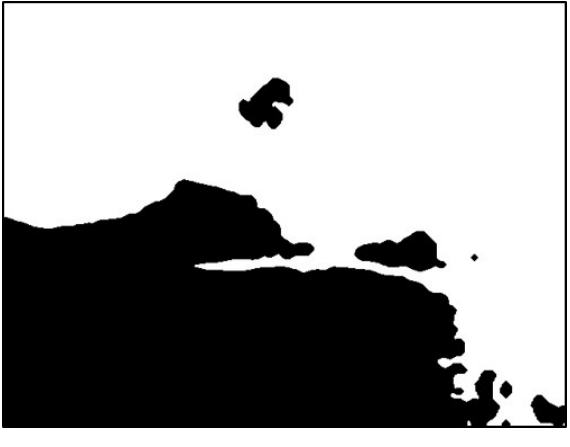
Figure 19. Result after erosion.